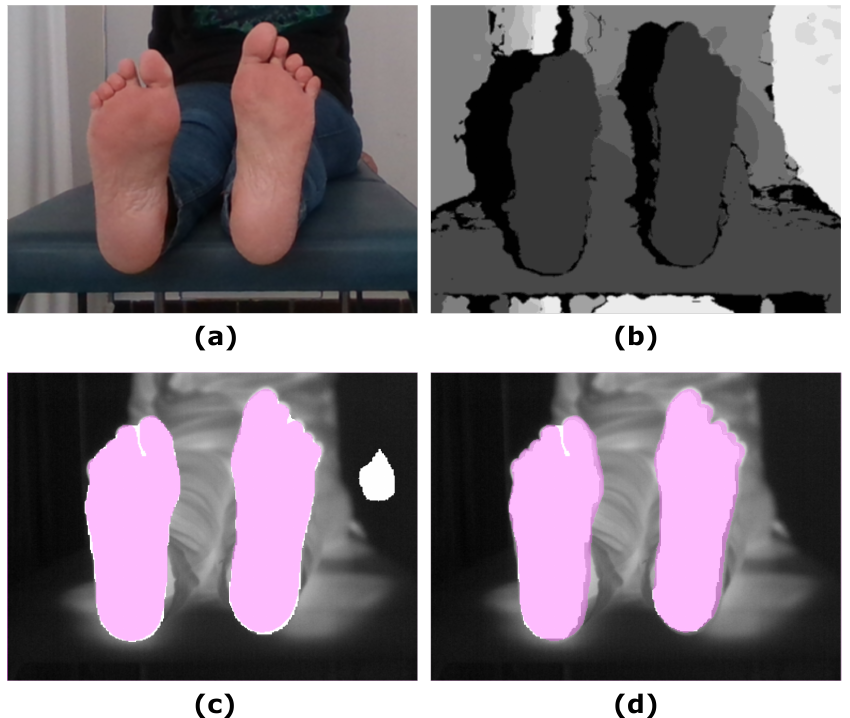
Figure 2. Illustrative example showing the input images and the final prediction including the improvement achieved by including the depth information: ( a ) RGB input image; ( b ) Depth input image; ( c ) IR original image and overlapping U-Net final prediction (white mask); ( d ) IR original image and overlapping UPD final prediction (white mask). The ground truth was overlapped (pink mask) to facilitate the comparison with the predictions.